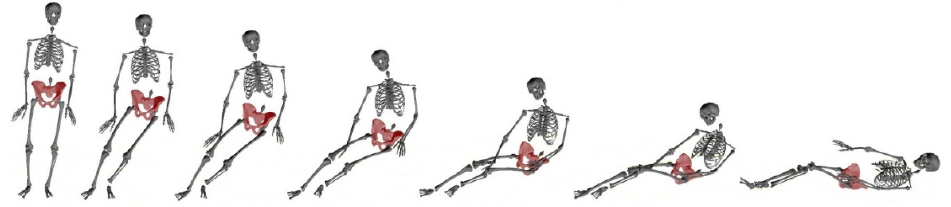
Figure 5. Biomechanical modeling based on 3D motion capture—a typical fall to the left.